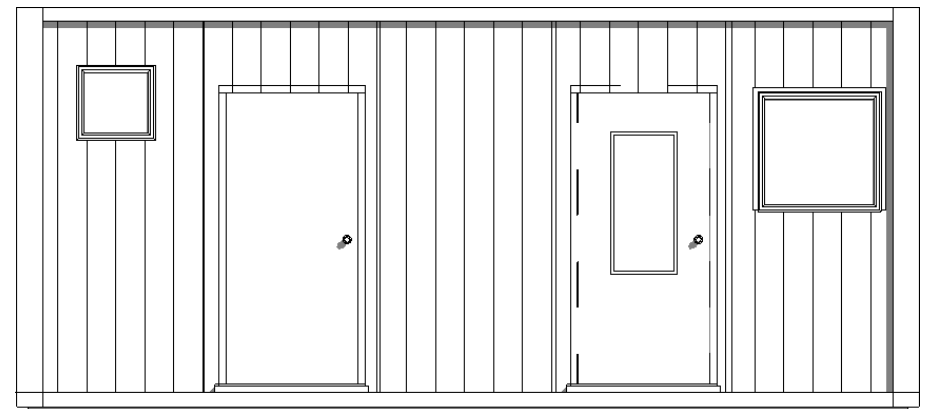
Figure 6. Panel types (from left to right: Sanitary window panel, door panel, full panel, glazed door panel, window panel, window panel).